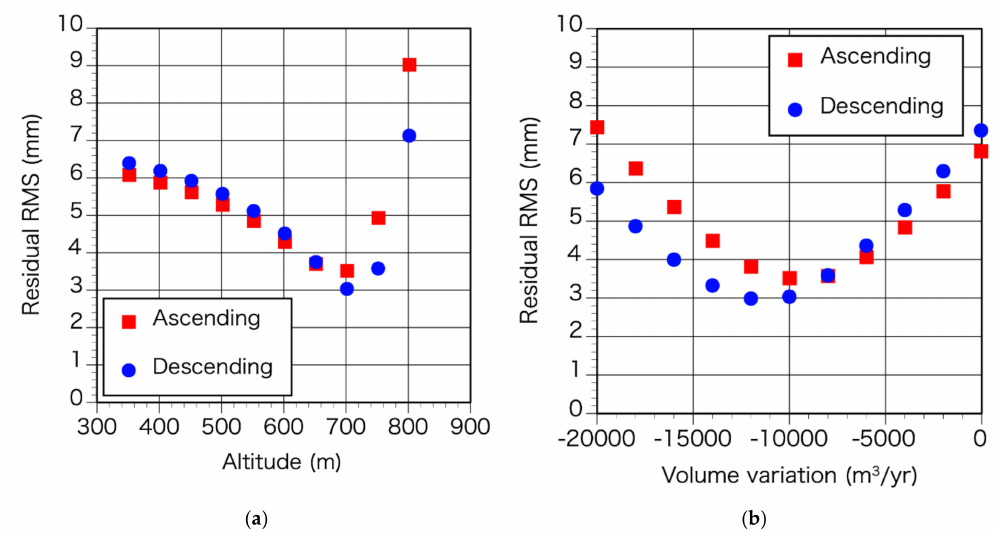
Figure 11. Residual root mean square (RMS) values estimated by forward modeling and varying ( a ) altitude and ( b ) volume variation. Altitude and volume variation changes every 50 m and 2000 m 3 / year, respectively. During forward modeling, the other parameters were held at optimum values (Table